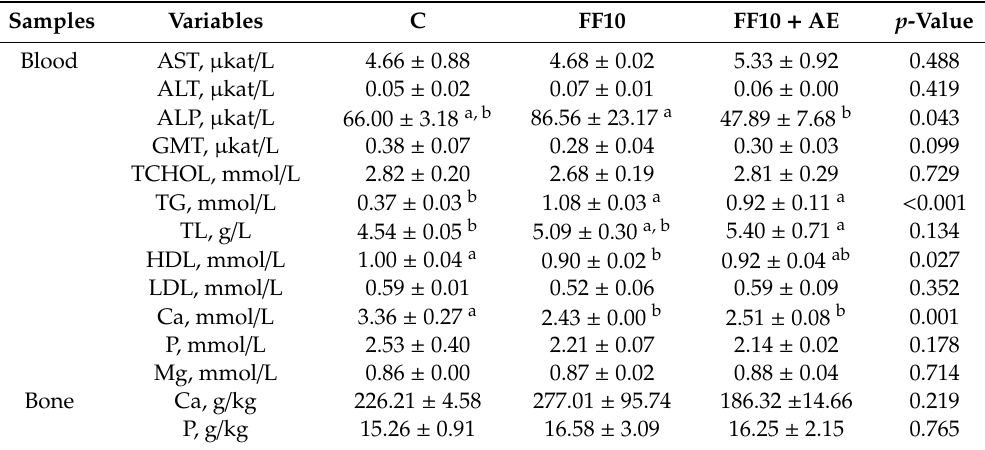
Table 3. The results of blood and bone analysis (means ± SD).